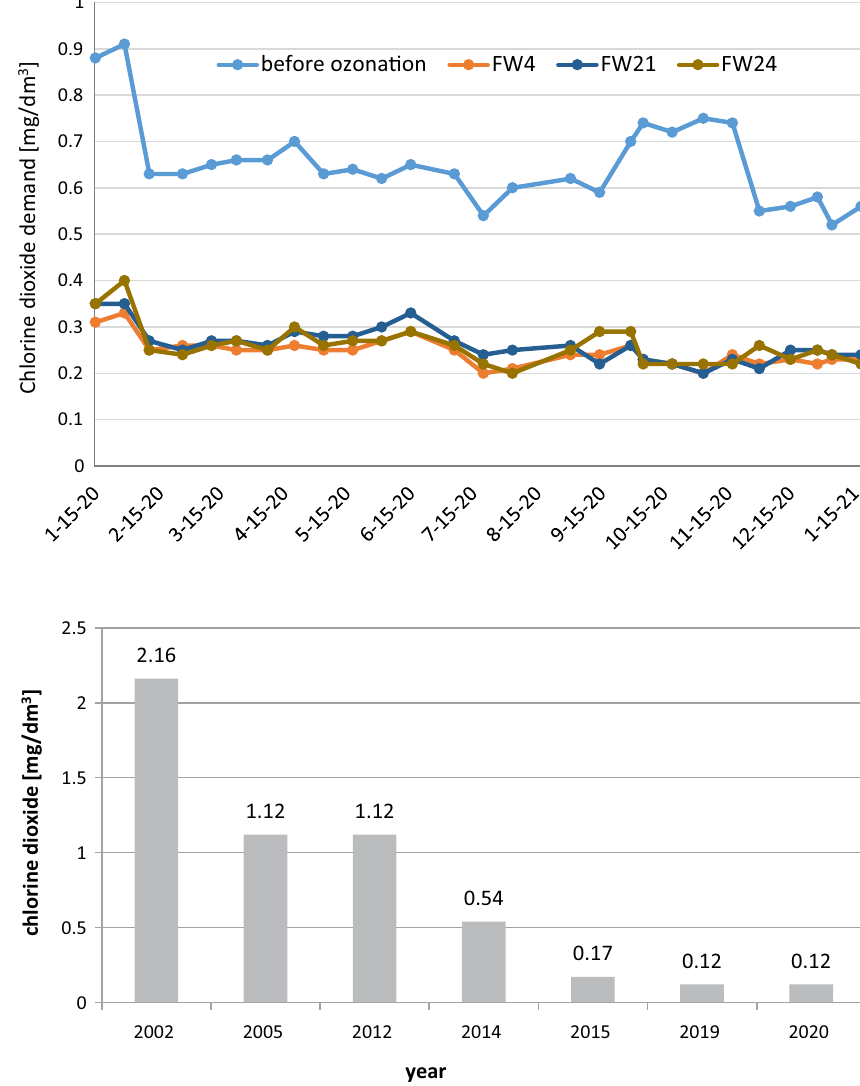
before ozona(cid:31)on